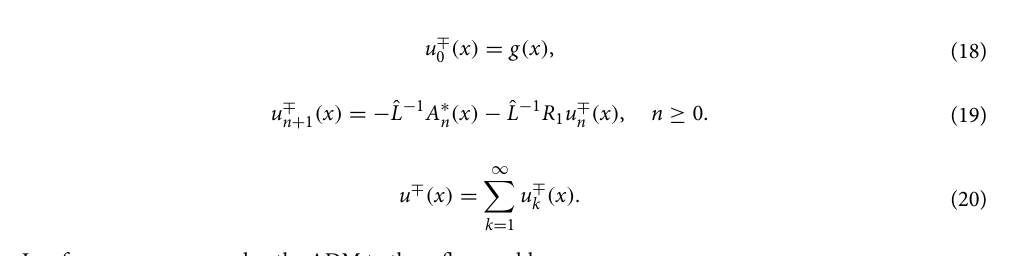
Figure 1. The geometry of the Couette and generalized Couette